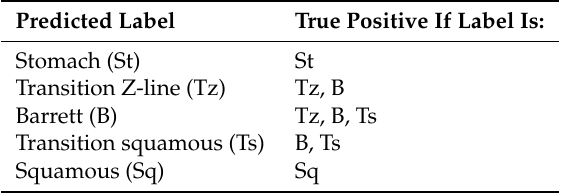
Table 1. Correspondence between predicted labels and ground-truth annotations of the